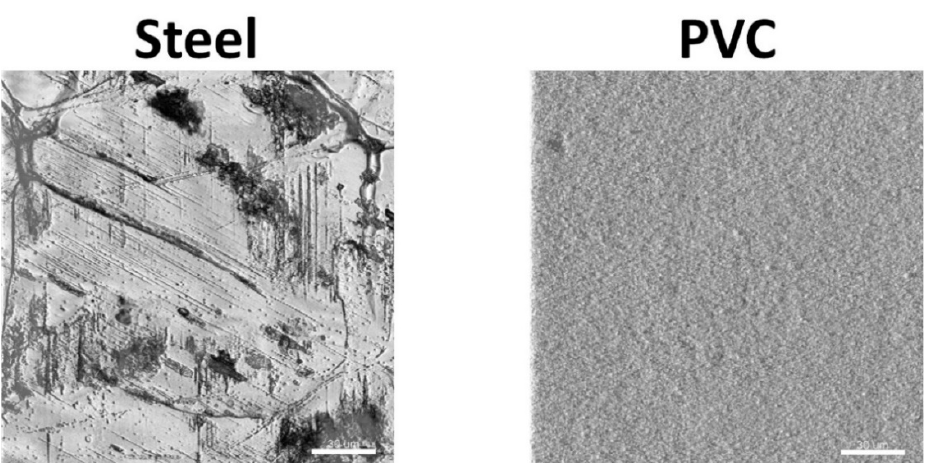
Figure 2. Characterization of the surface of coupons using confocal laser scanning microscopy. A detail of the surface topography of the steel and the PVC coupons by CLSM are shown (scale bar = 30 µm).